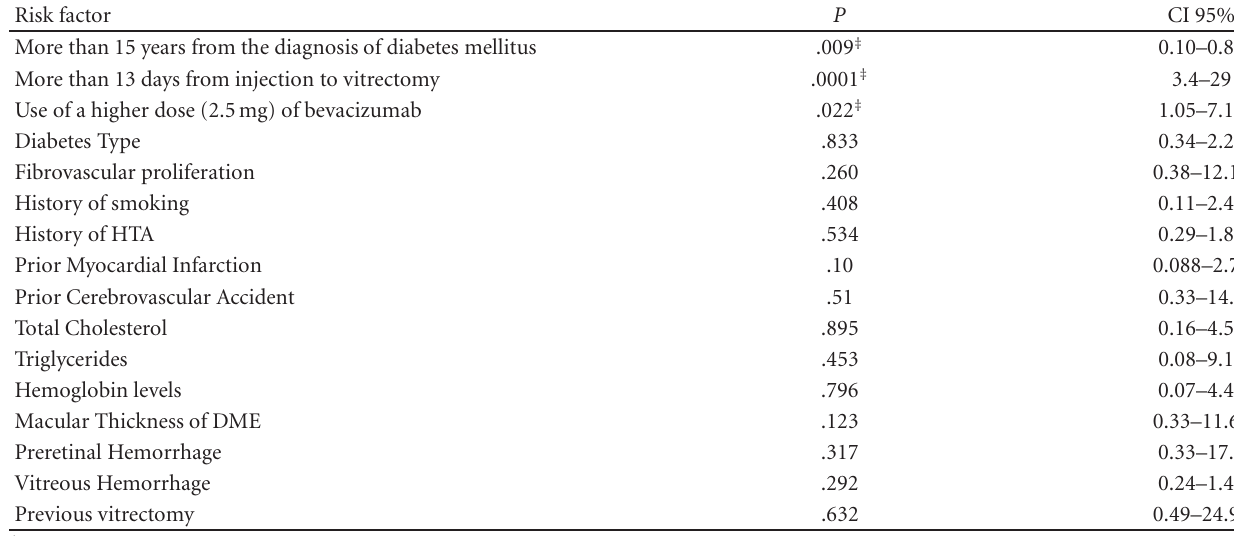
Table 2: Risk factors for tractional retinal detachment ∗